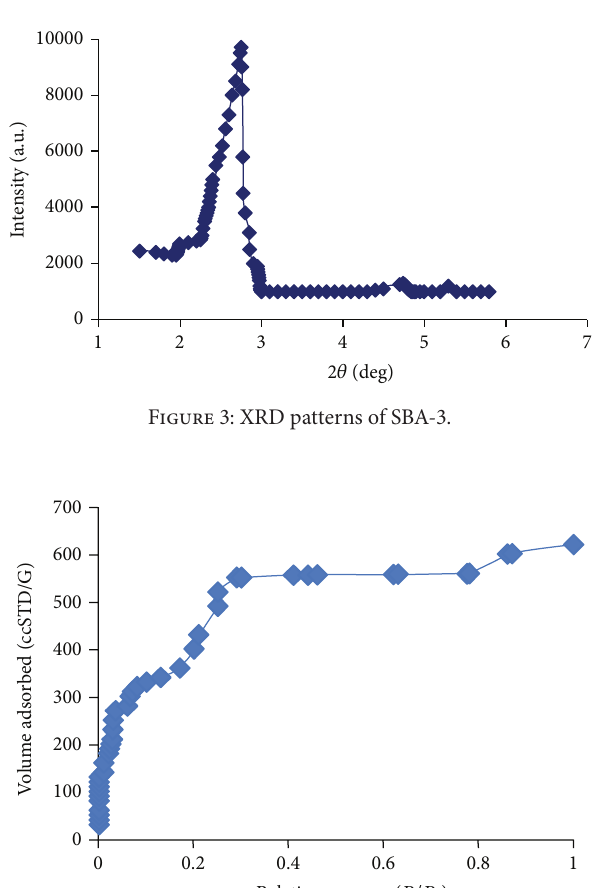
Figure 4: Adsorption desorption isotherm of nitrogen at 77 K on